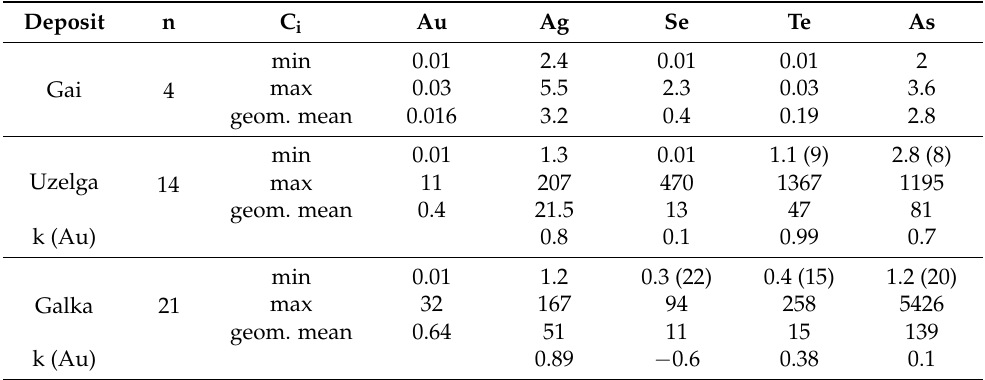
Figure 24. Binary diagrams of the contents of Au, Ag, Se, Te and As (ppm) in chalcopyrite of the VMS deposits of the Urals according to the LA-ICPMS data. Table 22. Contents of Au, Ag and some impurities in sphalerite of VMS deposits according to LA-ICP-MS data (ppm). Deposit